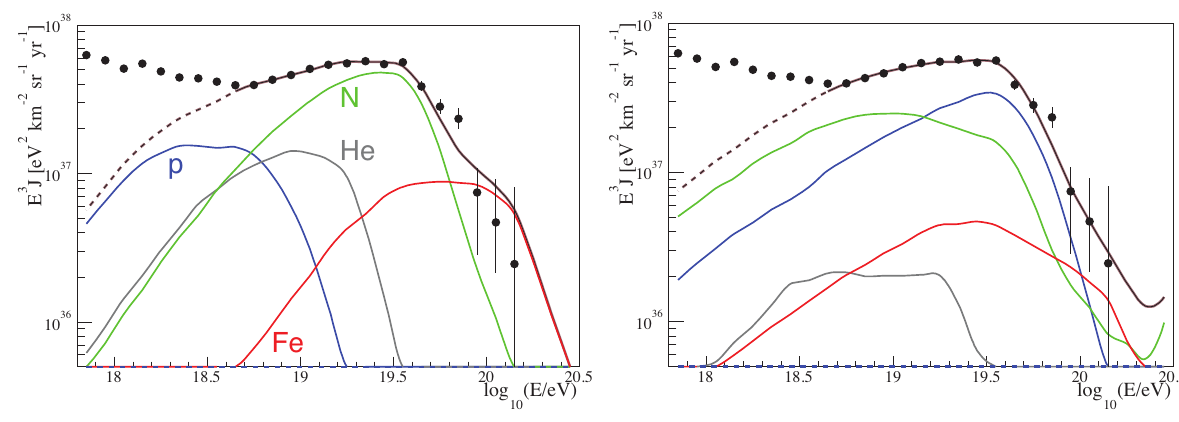
Figure 2:Examples of fluxes of different mass groups (as indicated) for describing the PAO spectrum and composition data. 10 Two scenarios are shown: particles being accelerated up to a maximum rigidity (left) and particles undergoing photodisintegration during propagation (right).